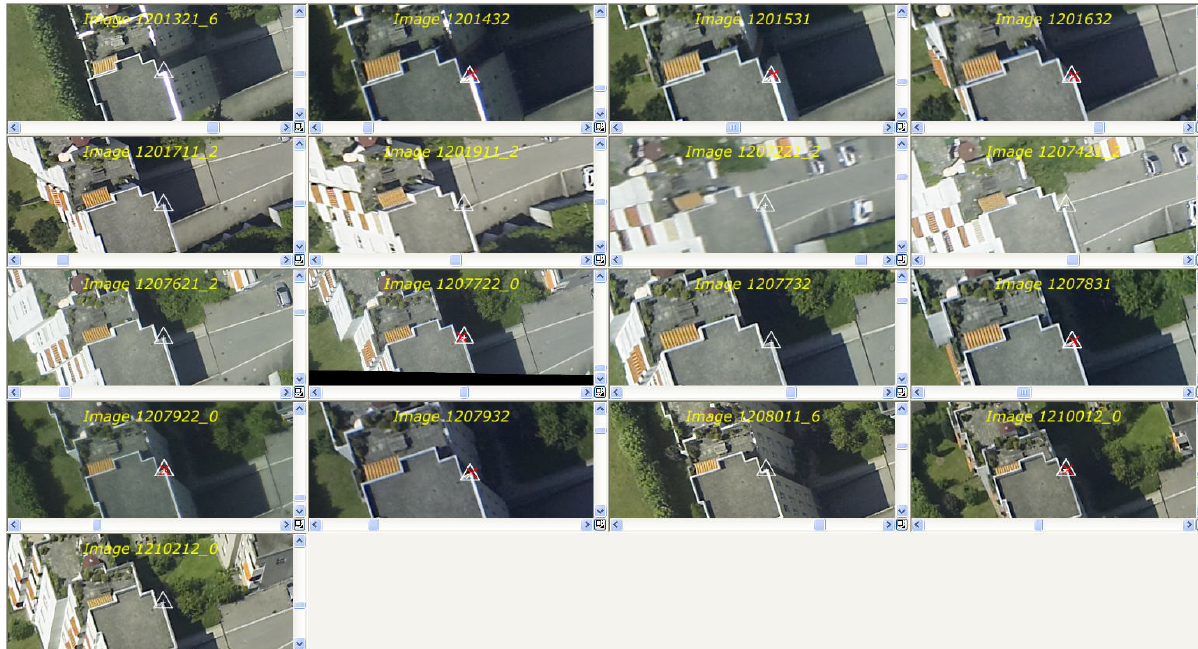
Figure 2: Manual Measurement of Tie Points in 17 Oblique Images with Match